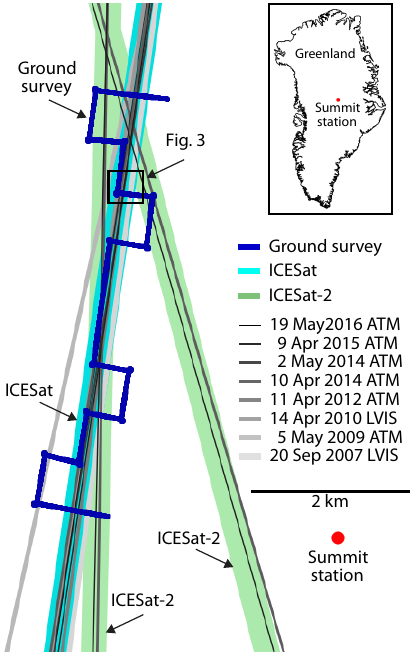
Figure 1. Map of the Summit Station area including the represen- tative ground-based GPS survey line (blue line); airborne lidar sur- veys (gray lines, thicker lines occur earlier); ICESat ground track no. 0412 (cyan line); ICESat-2 ground tracks (green lines); and Summit Station (red dot). The distance between Summit Station and the southern end of the traverse is ∼ 3km; the distance between Summit Station and the northern end of the traverse is ∼ 6.5km. Relative to the trend of ICESat track no. 0412, the ground-based GPS survey line is oriented both along-track and across-track in or- der to better characterize the surface